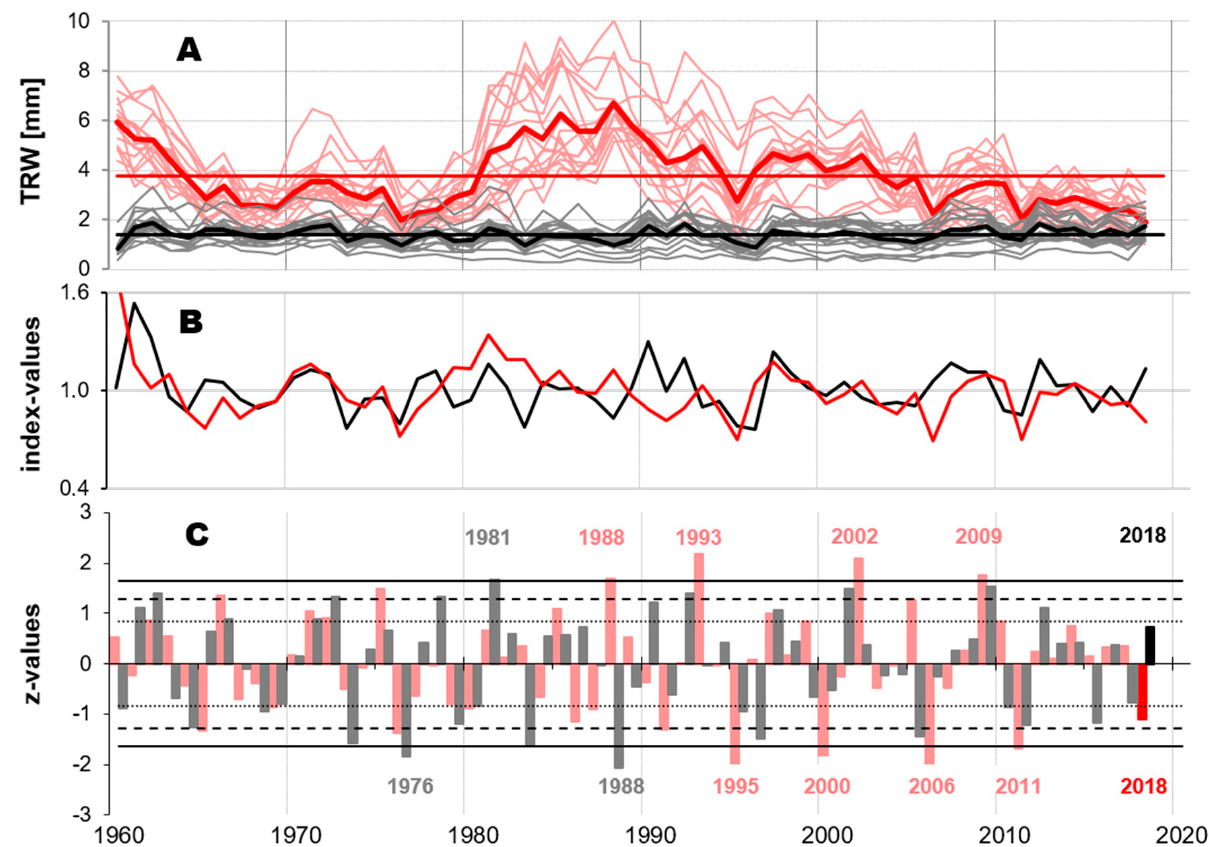
Figure 2. The tree mean curves of 15 trees each for EIF (light red/red) and UWM (grey/black) with corresponding site mean curves (bold lines) and average growth rates (red/black horizontal lines) ( A ), mean indexed tree – ring chronologies ( B ), and z – transformed Croppervalues C yz indicating the so – called pointer years of above – /below – average growth ( C ). The horizontal lines in Part C illustrate the significance levels of the growth anomalies (dotted: C yz = ± 0.845 for weak, broken: C yz = ± 1.28 for strong, and lined: C yz = ± 1.645 for extreme pointer years). Extreme pointer years are marked by years, light red for EIF, grey for UWM, and, for 2018, the bars are highlighted in stronger colors (red and black).